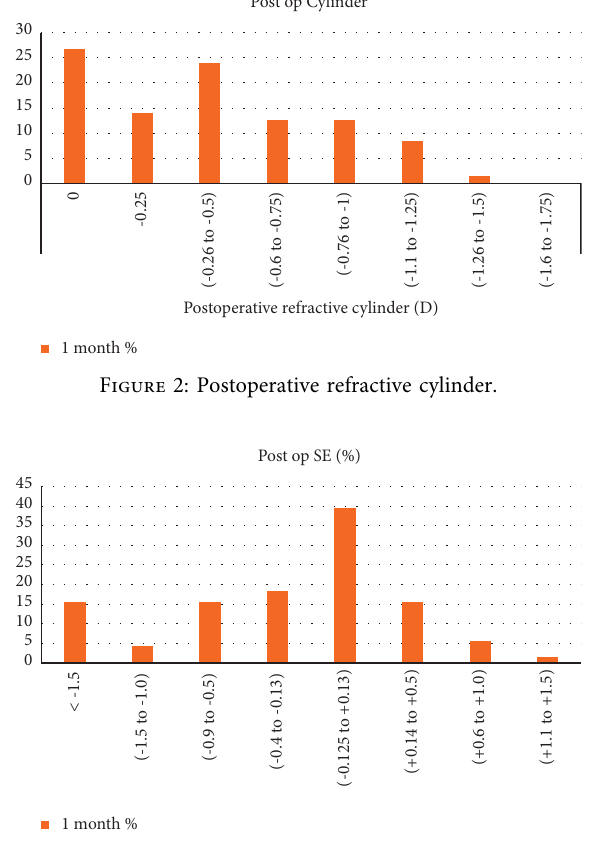
Figure 3: Postoperative spherical